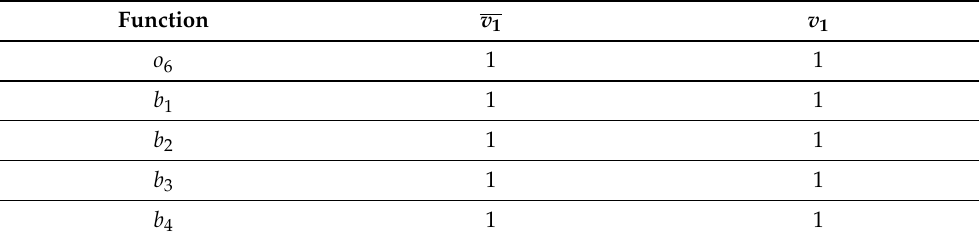
Table 8. Table of block CM. Function v 1 v 1 D 1 1